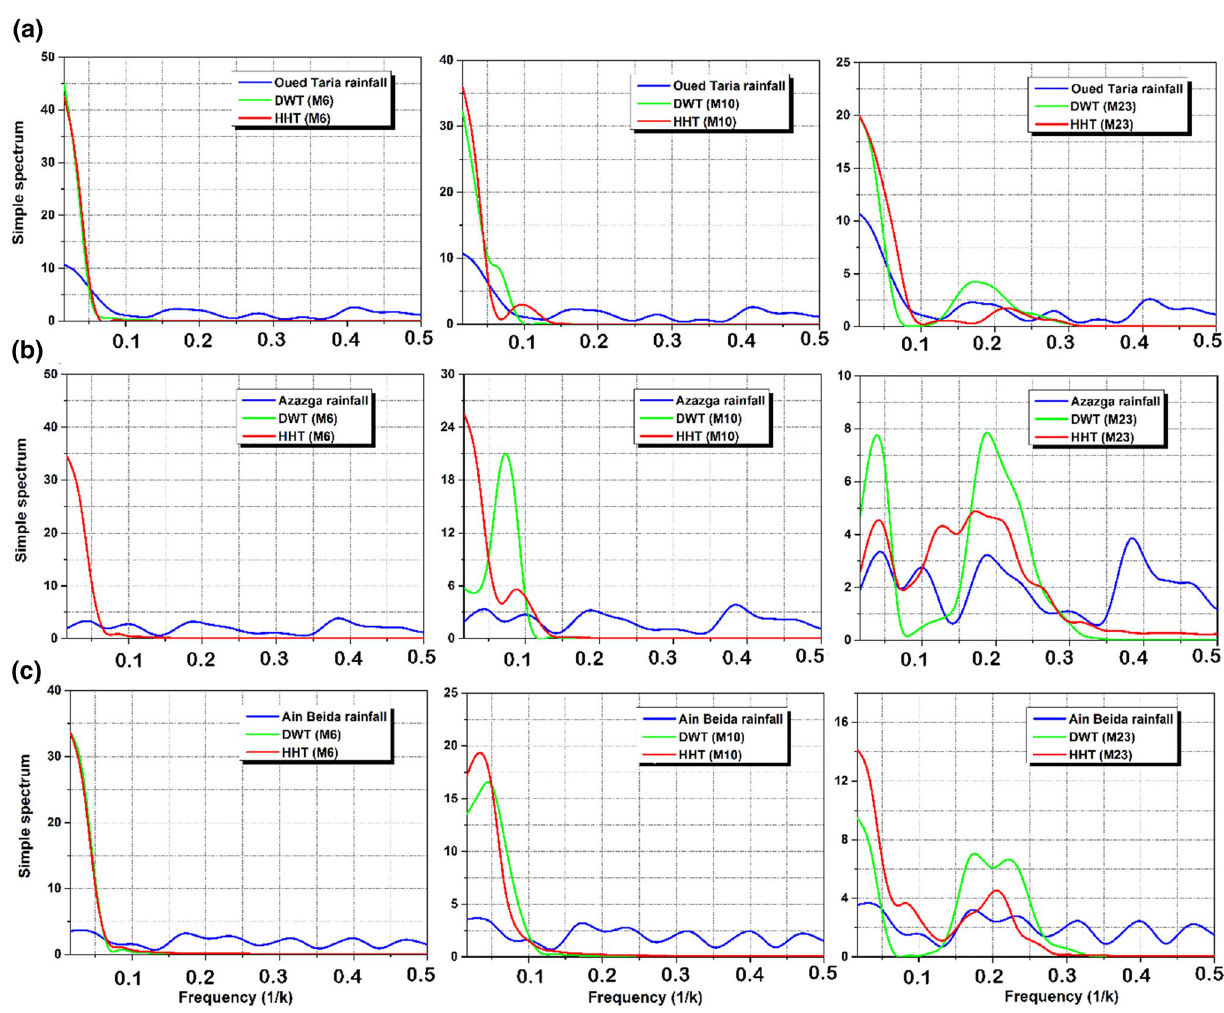
Fig. 11 Spectrum analysis of rainfall series (blue line) and some proposed models (M6, M10, and M23) using DWT (green line) and HHT (red line) for a Oued Taria, b Azazga, and c Ain Beida